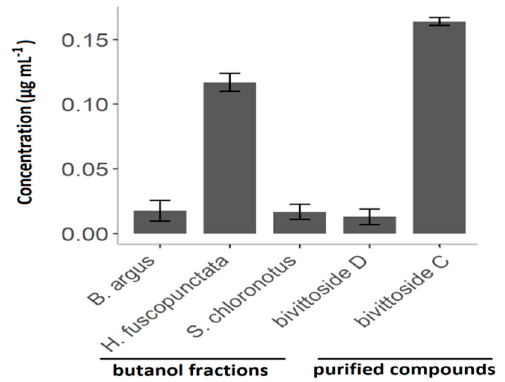
Figure 11. LC 50 concentration of the sea cucumber crude extracts against brine shrimp larvae after 48 h. Results express mean values ± standard error.